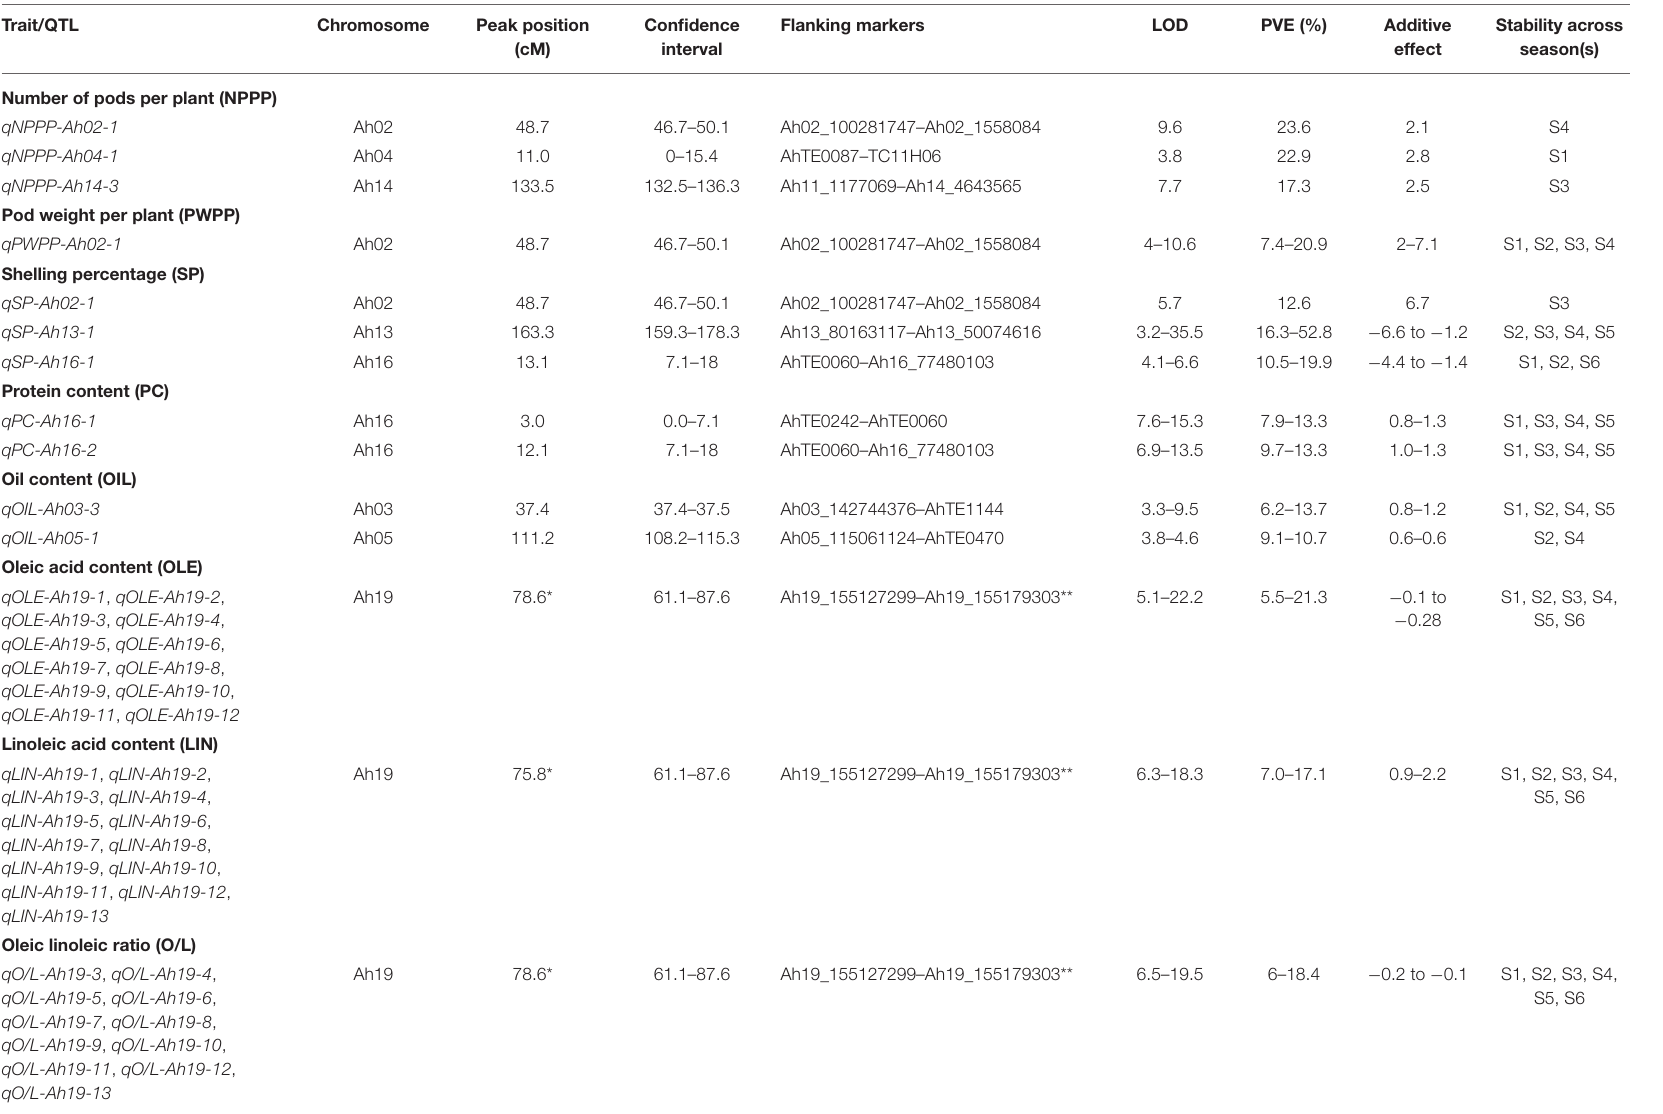
TABLE 1 | Major main effect quantitative trait loci (QTLs) identified for productivity and quality traits across seasons in the recombinant inbred line (RIL) population of TMV 2 and TMV 2-NLM of peanut. Trait/QTL Chromosome Peak position